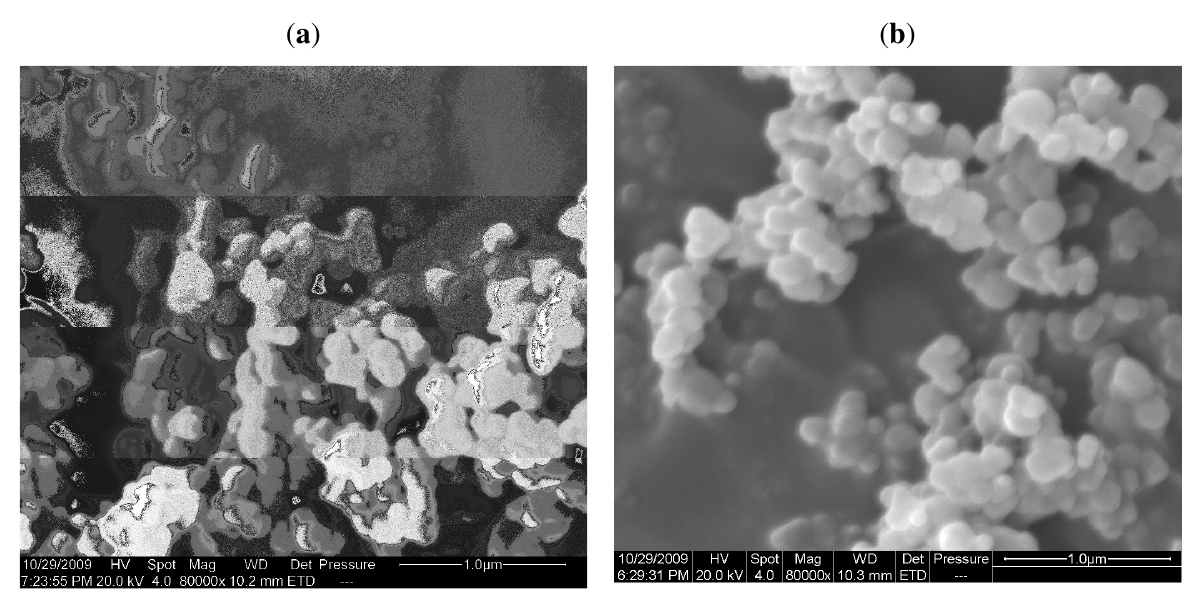
and ( b ) 4 µ mol CuPp ( 4a )/1 g TiO 2